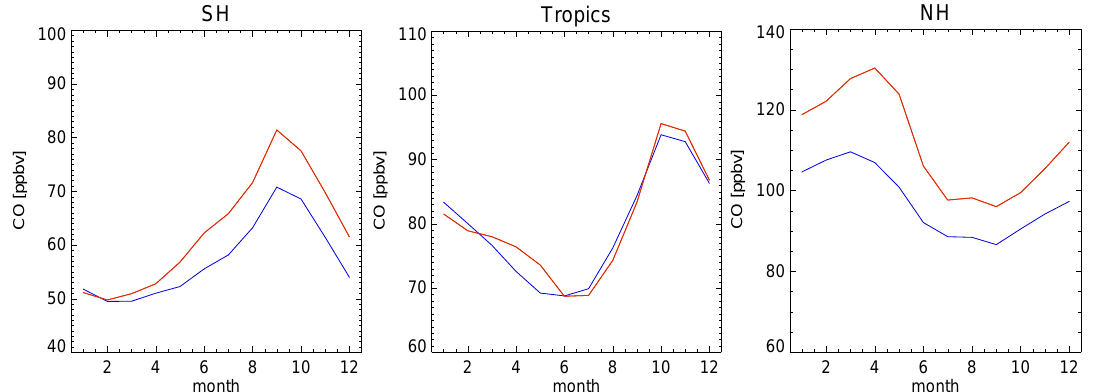
Fig. 5. The annual cycle of mean, mass weighted CO in observations (red) and in TM5 (blue) for the MOPITT 500-hPa retrieval level.